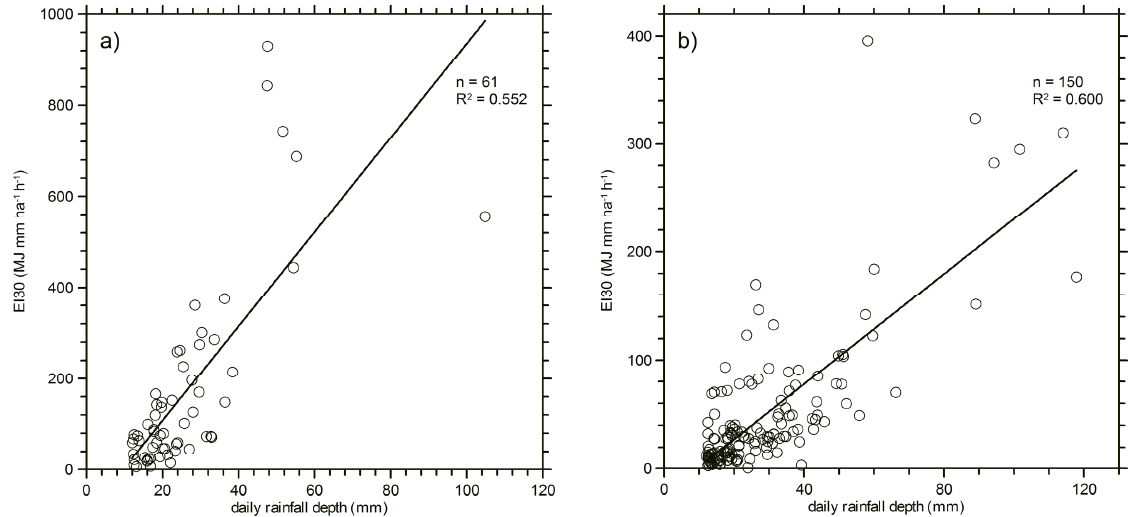
Figure 5. Fig. 5. Scatter plots of daily rainfall erosivity versus daily rainfall for the Vallcebre weather station: (a) summer and (b) rest of the seasons.